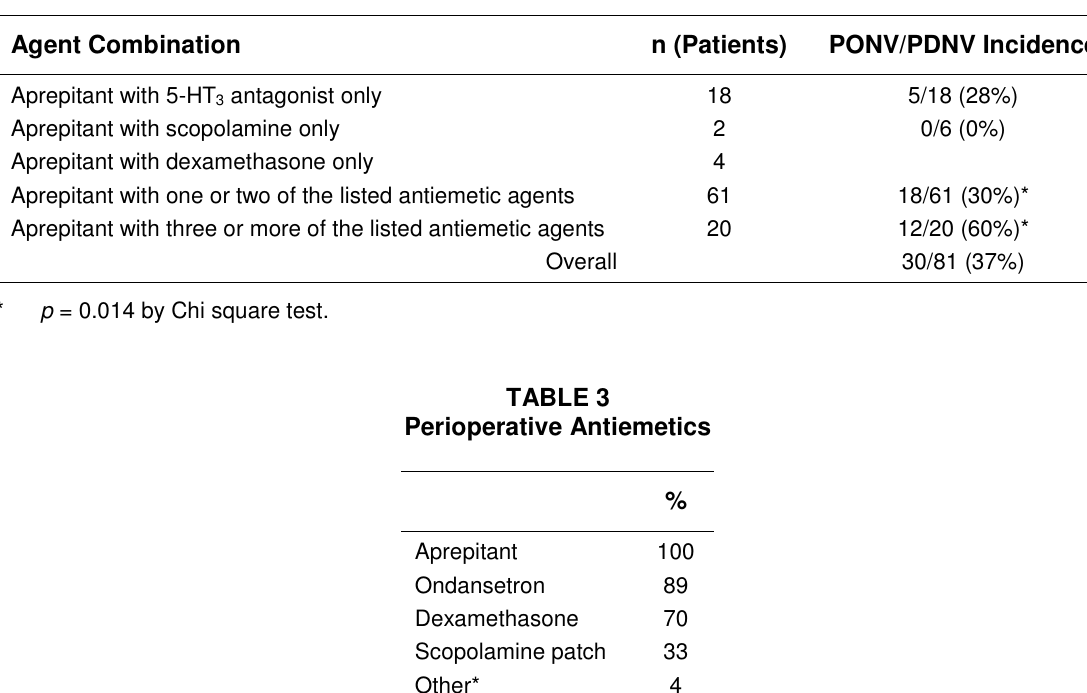
Number of Antiemetics Received and PONV/PDNV Incidence